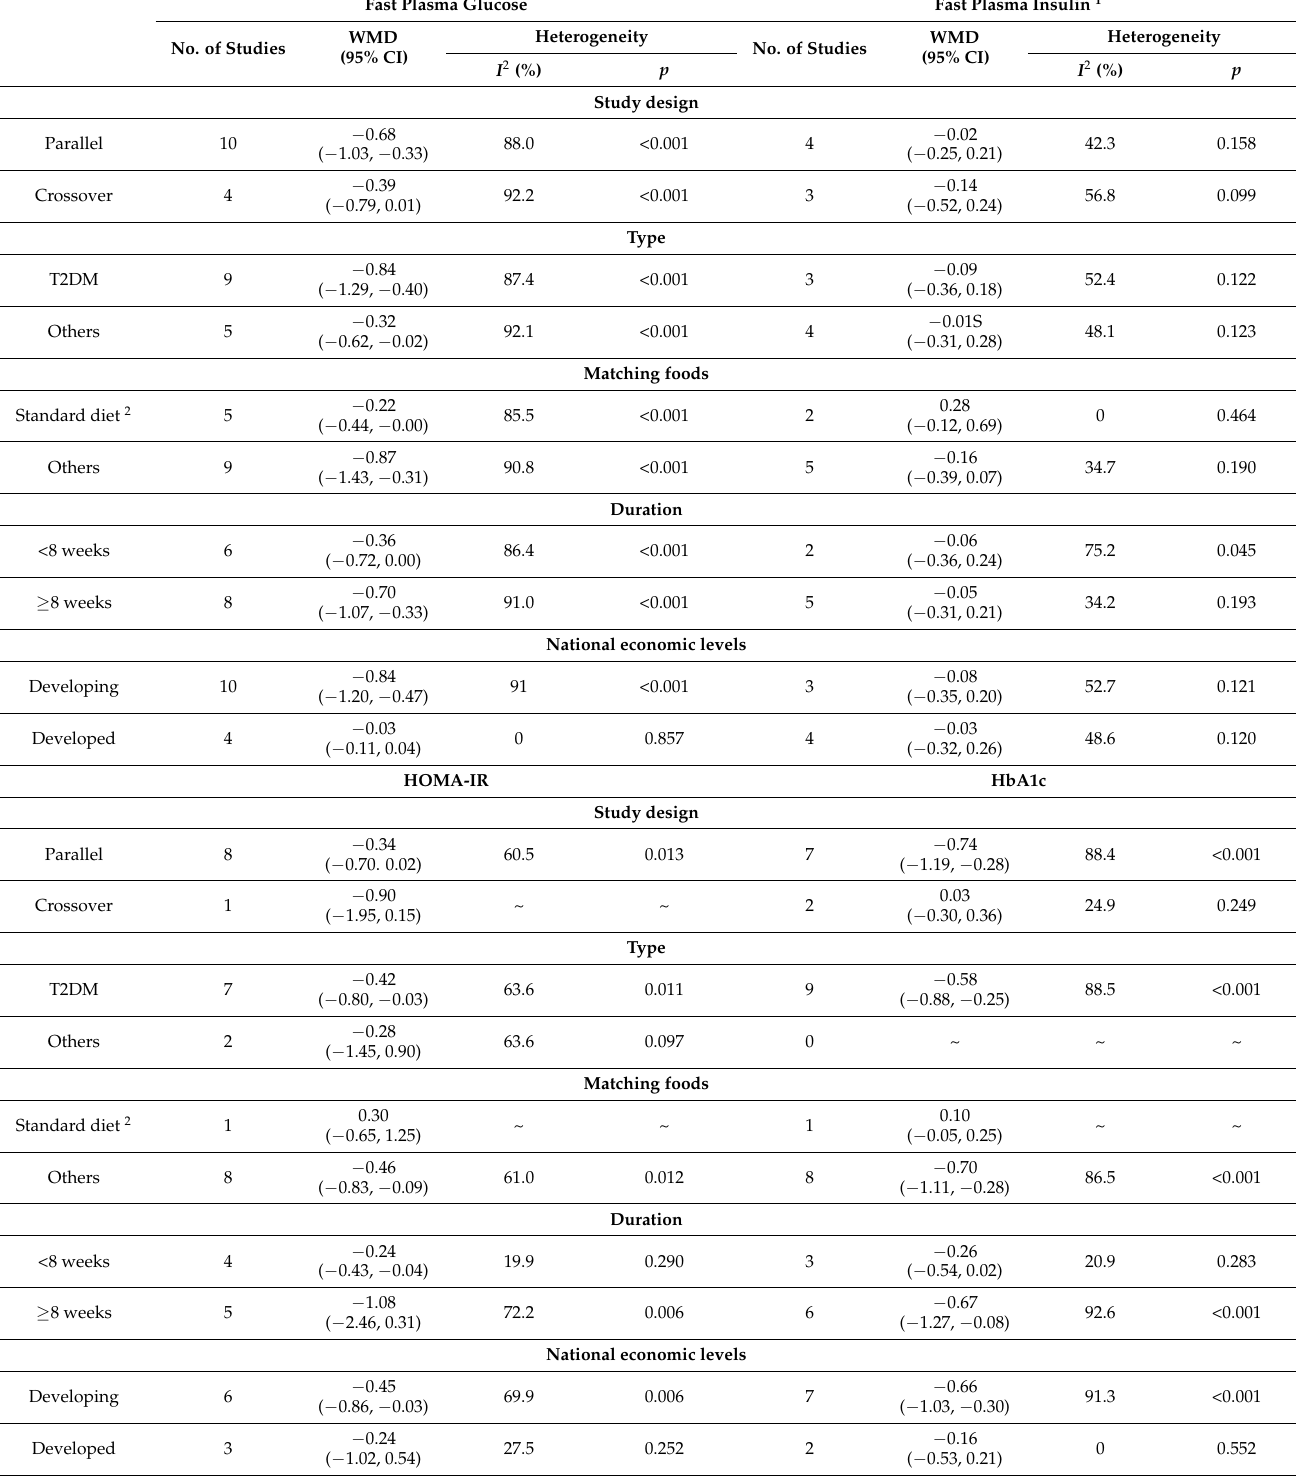
Table 2. Subgroup analysis of the effects of whole grain consumption on glycaemic control in diabetic